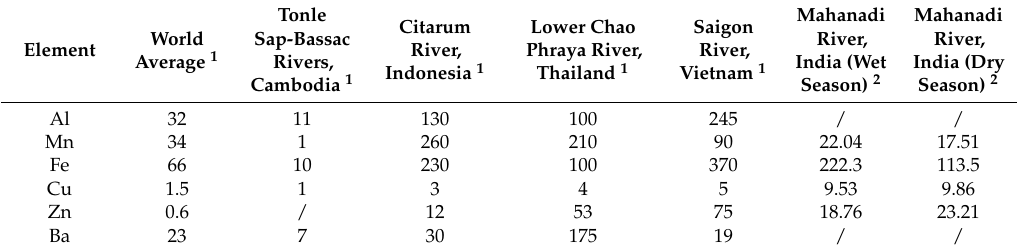
Table 3. The concentrations of dissolved heavy metals ( µ g/L) in southeast Asian